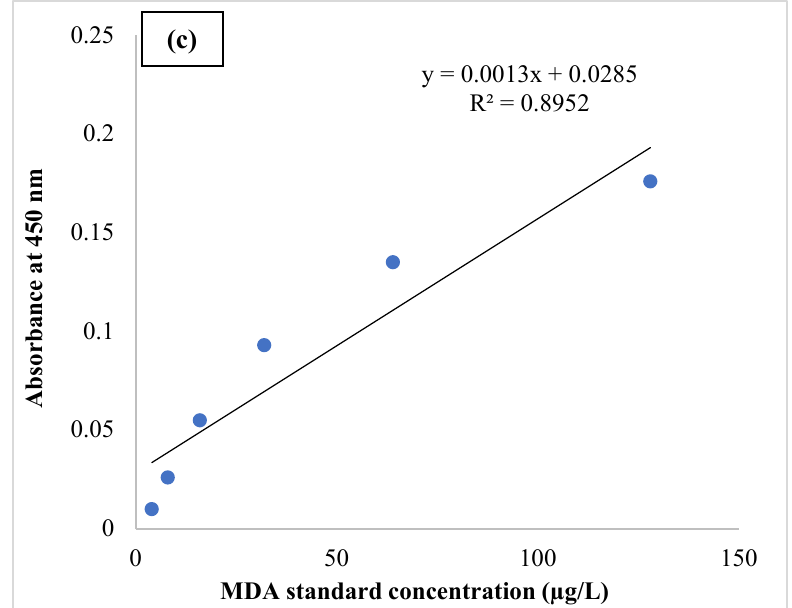
Figure 1. Standard curves of Pb ( a ), 8-oxo-Gua ( b ), and MDA ( c ).